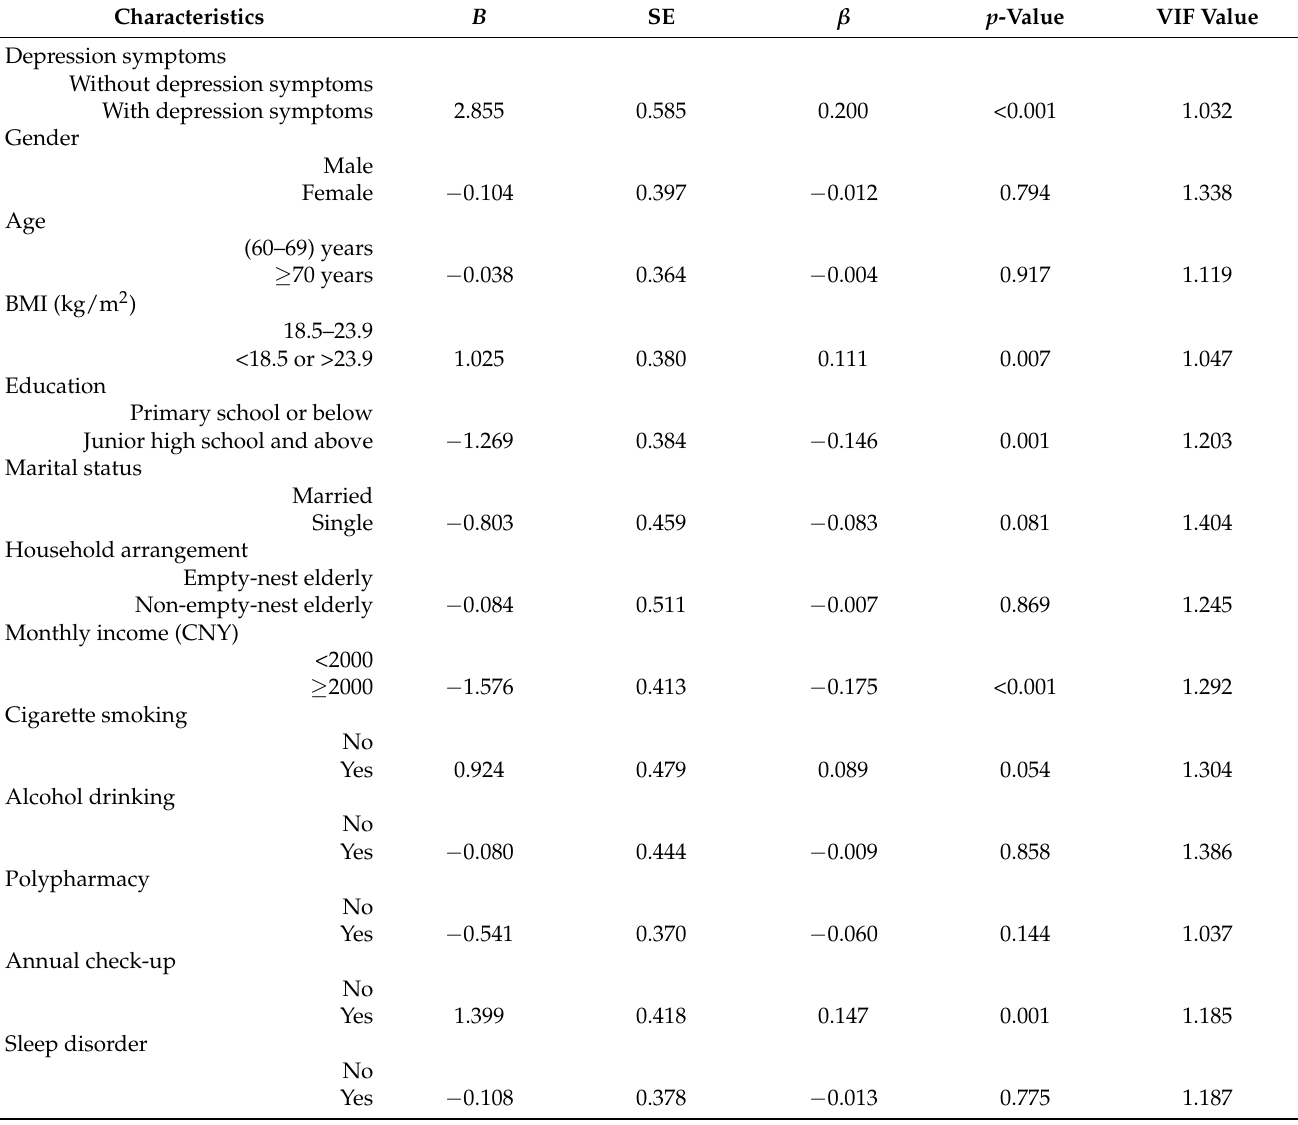
Table 2. Risk Factors for loneliness ( n = 527).